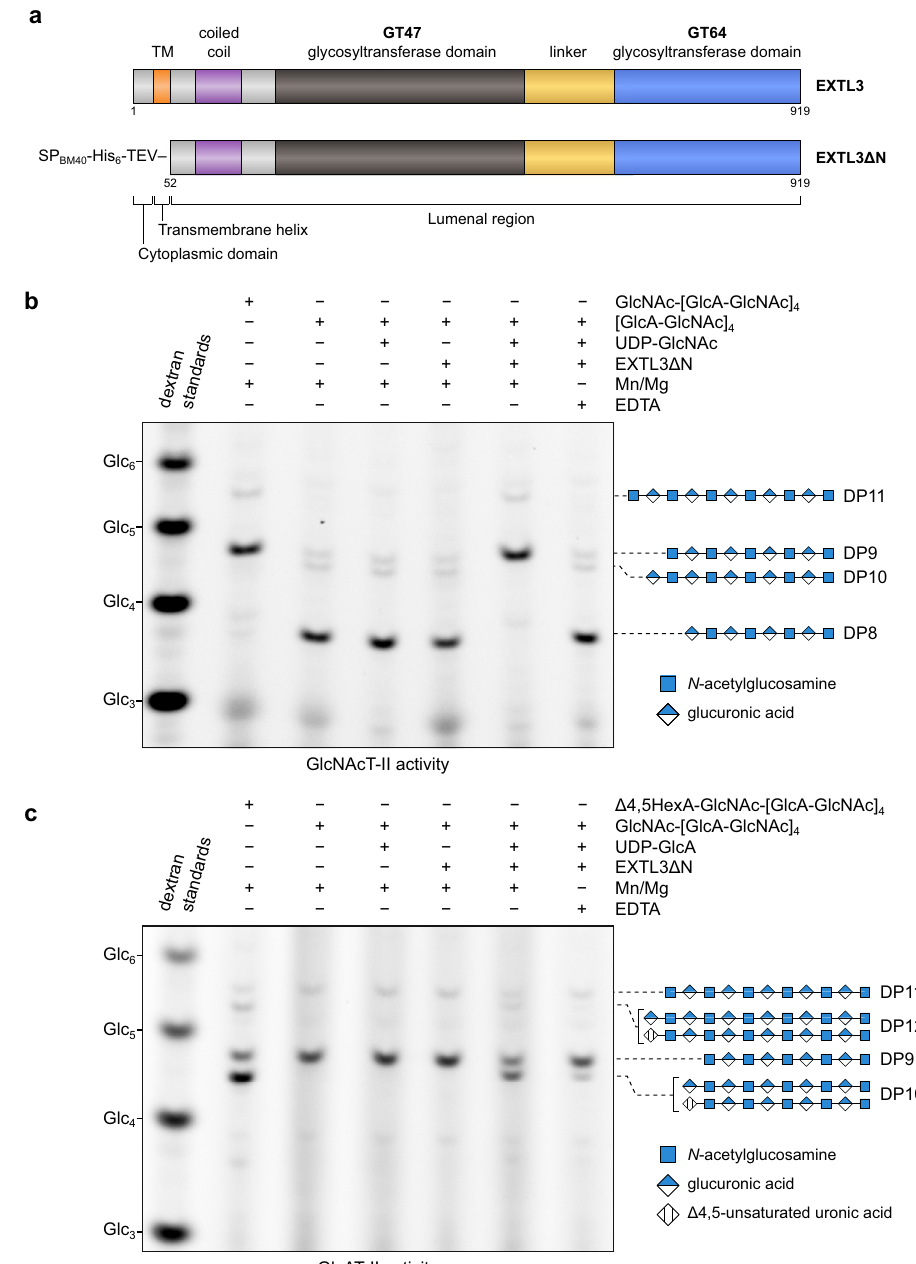
Fig. 1 Carbohydrate electrophoresis can be used to observe heparosan-extending activity in preparations of EXTL3 Δ N, a secretory form of EXTL3. a Domain annotation of full-length EXTL3 and EXTL3 Δ N, respectively. b , c Polysaccharide analysis by carbohydrate electrophoresis (PACE) gels showing reaction products of EXTL3 Δ N GlcNAcT-II and GlcAT-II assays, respectively. Secretory EXTL3 Δ N was expressed in human embryonic kidney cells and puri fi ed from the culture medium. Acceptors (DP8 [GlcA-GlcNAc] 4 or DP9 GlcNAc-[GlcA-GlcNAc] 4 ) were prepared enzymatically from the E. coli K5- derived oligosaccharide Δ 4,5HexA-GlcNAc-[GlcA-GlcNAc] 4 (DP10). The DP8 and DP9 acceptor preparations also contained a small amount of DP10 [GlcA-GlcNAc] 5 or DP11 GlcNAc-[GlcA-GlcNAc] 5 oligosaccharide, respectively. For each assay, acceptor was incubated with a combination of EXTL3 Δ N, UDP-GlcNAc, UDP-GlcA, MnCl 2 and MgCl 2 , and/or EDTA (as indicated) for 16 h. The products were subsequently derivatised with a fl uorophore and separated by PACE. Results representative of two biologically independent